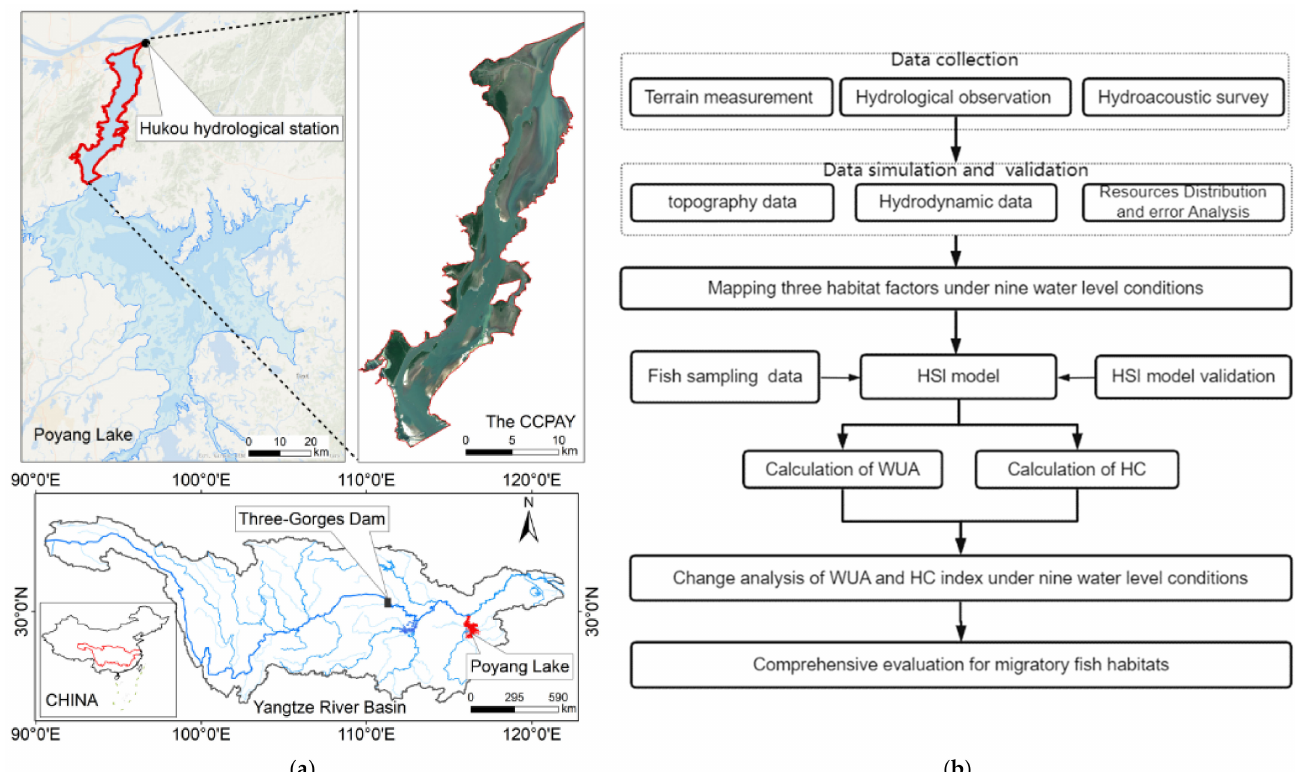
Figure 1. The ( a ) study area and ( b ) outline of the major